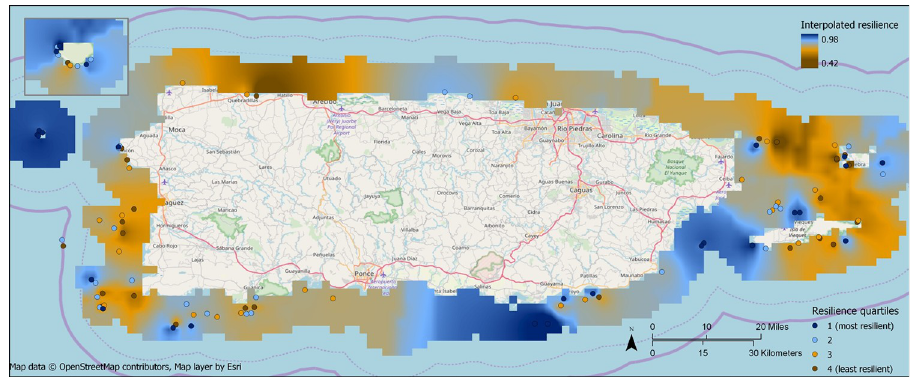
Fig 3. Resilience scores interpolated up to 10 km from the coast using inverse distance weighting of the resilience scores of survey sites. Sites outside the interpolation raster were not used in the interpolation. Not all of the interpolated locations historically had coral reefs or do currently have